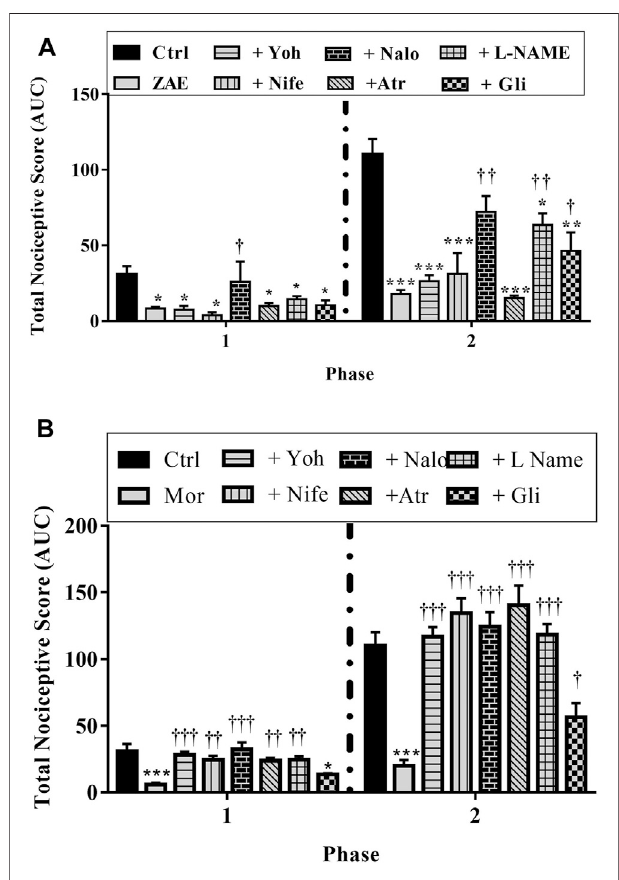
FIGURE 9 | Effect of pre-treatment of mice with yohimbine, nifedipine, naloxone, atropine, L- NAME, and glibenclamide on the anti-nociceptive pro fi le of (A) ZAE(300 mg/kg, p. o.) and (B) morphine (3 mg/kg, i.p.) inphase 1andphase 2offormalin-inducednociception.Each columnrepresents the mean of fi ve animals and the error bars indicate S.E.M. *** p < 0.001 comparedtorespectivevehicle-treatedcontrols; ††† p < 0.001, †† p < 0.01and † p < 0.05 compared to either ZAE 100 mg/kg or morphine 3 mg/kg (all one- way ANOVA followed by Tukey ’ s post hoc test).